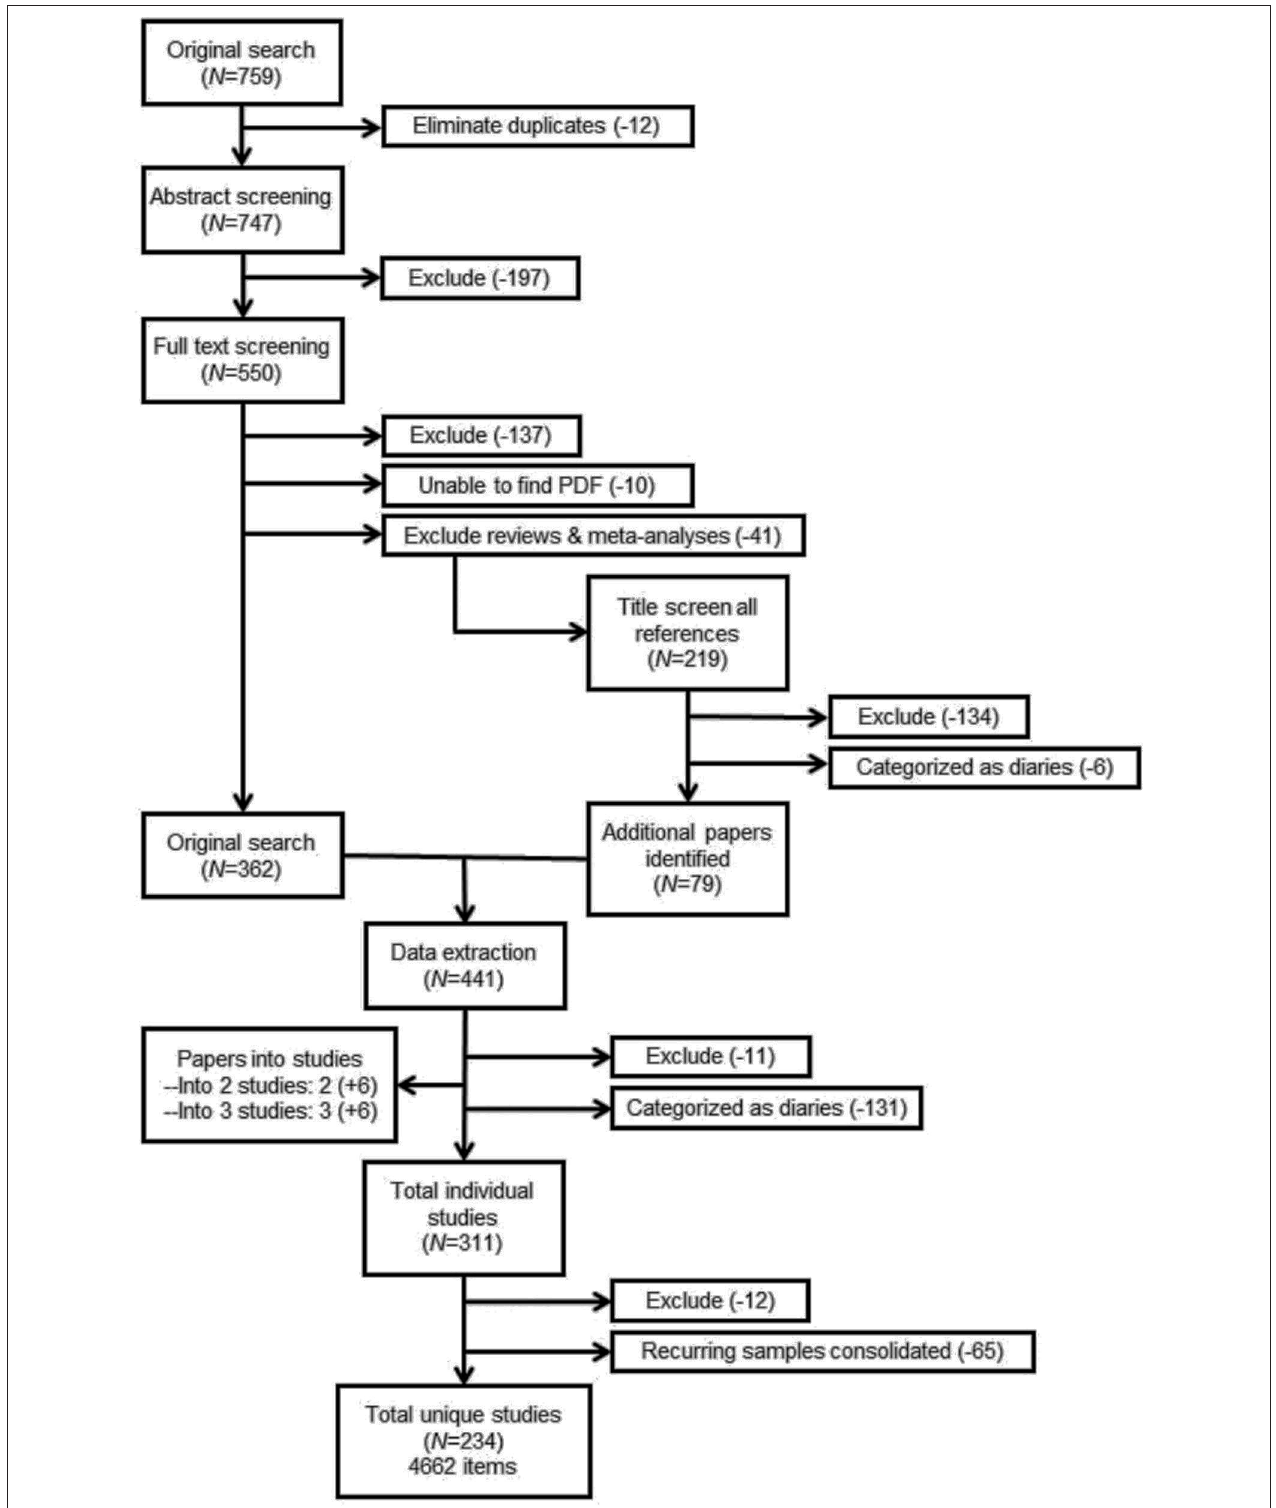
FIGURE 1 | PRISMA flowchart. Total item count includes items that were unspecified or missing in-text. Further explanation of the full sample size can be found in the section Results.